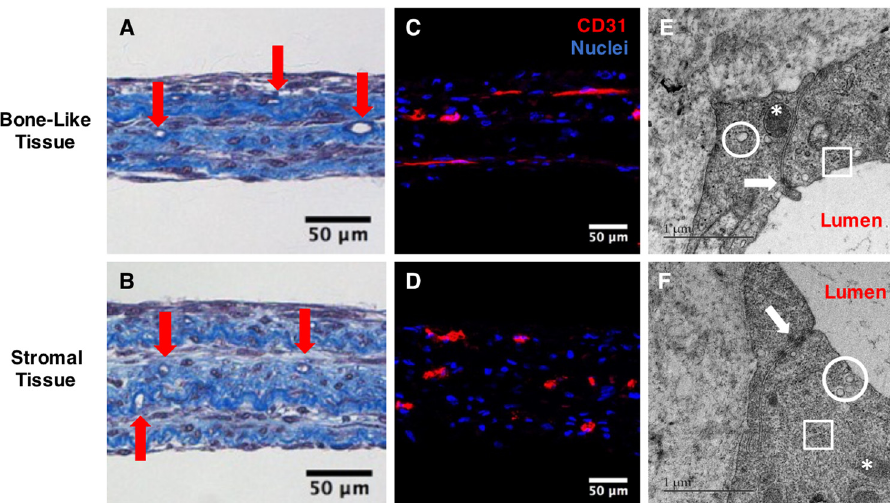
Figure 3. Characterization of the capillary network in prevascularized substitutes after two weeks of HUVEC network maturation. Masson’s trichrome staining of transverse sections of prevascularized tissues revealed the presence of lumen-like structures (red arrows) in both bone-like ( A ) and stromal tissues ( B ). Scale bars, 50 µm. CD31-positive structures (red) were observed in both tissue types after the immunolabeling of cryosections ( C ) and ( D ). Nuclei were stained in parallel with Hoechst (blue). Scale bars, 50 µm. Transmission electron microscopy images show typical ultrastructural features of blood capillaries, such as caveolae (white circles), Weibel–Palade bodies (white asterisks), tight junctions (white arrows), glycogen inclusions (white squares), and lumens ( E ) and ( F ). Scale bars, 1 µm.